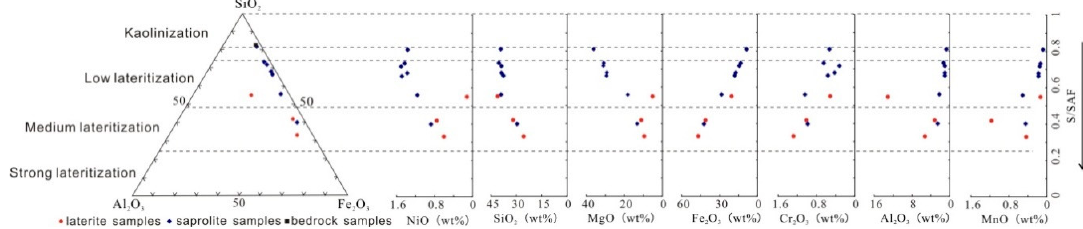
Figure 9. Lateritization degree of the Yuangjiang lateritic Ni profile and its relationship to element concentrations of different samples.